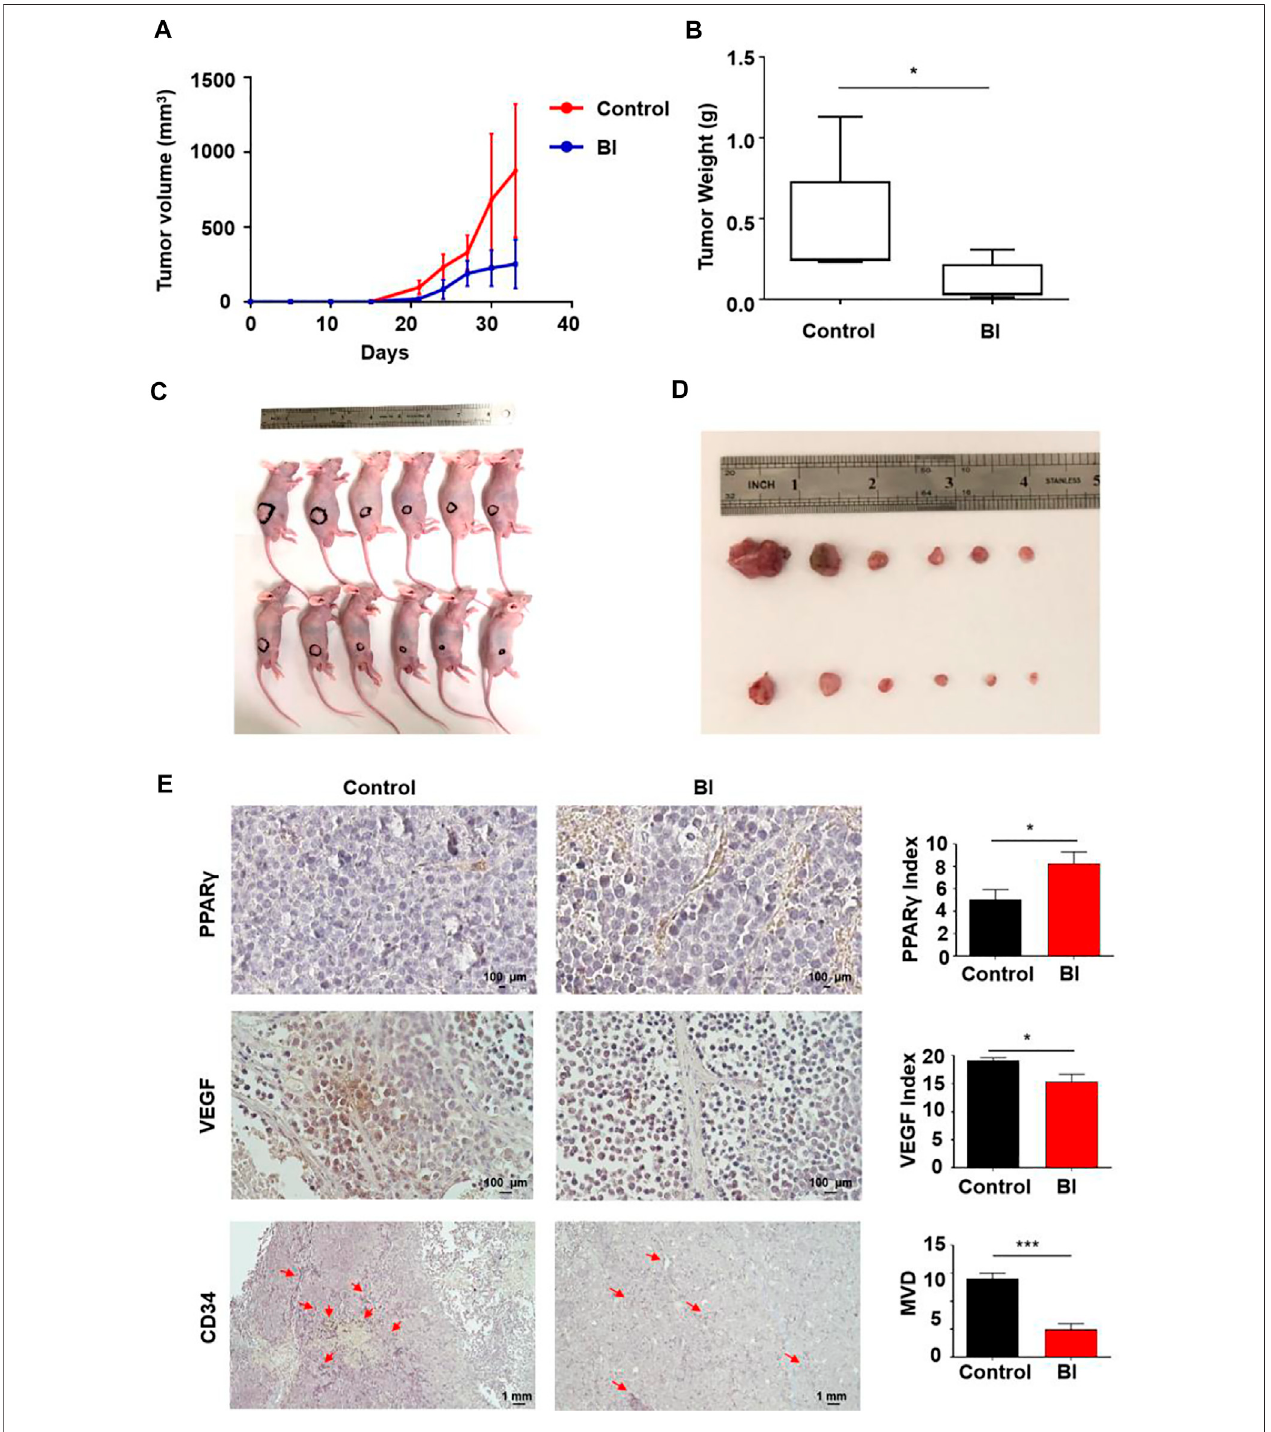
FIGURE2| Anti-MMangiogenesisofBIinanMMxenograftmousemodel. (A – D) Mice injected subcutaneouslywithRPMI8226cells.Afterinjection withcontrolor BI, the tumor volume was recorded. (E) Immunohistochemistry labeled PPAR γ , VEGF, and CD34 in mouse xenograft tumors.